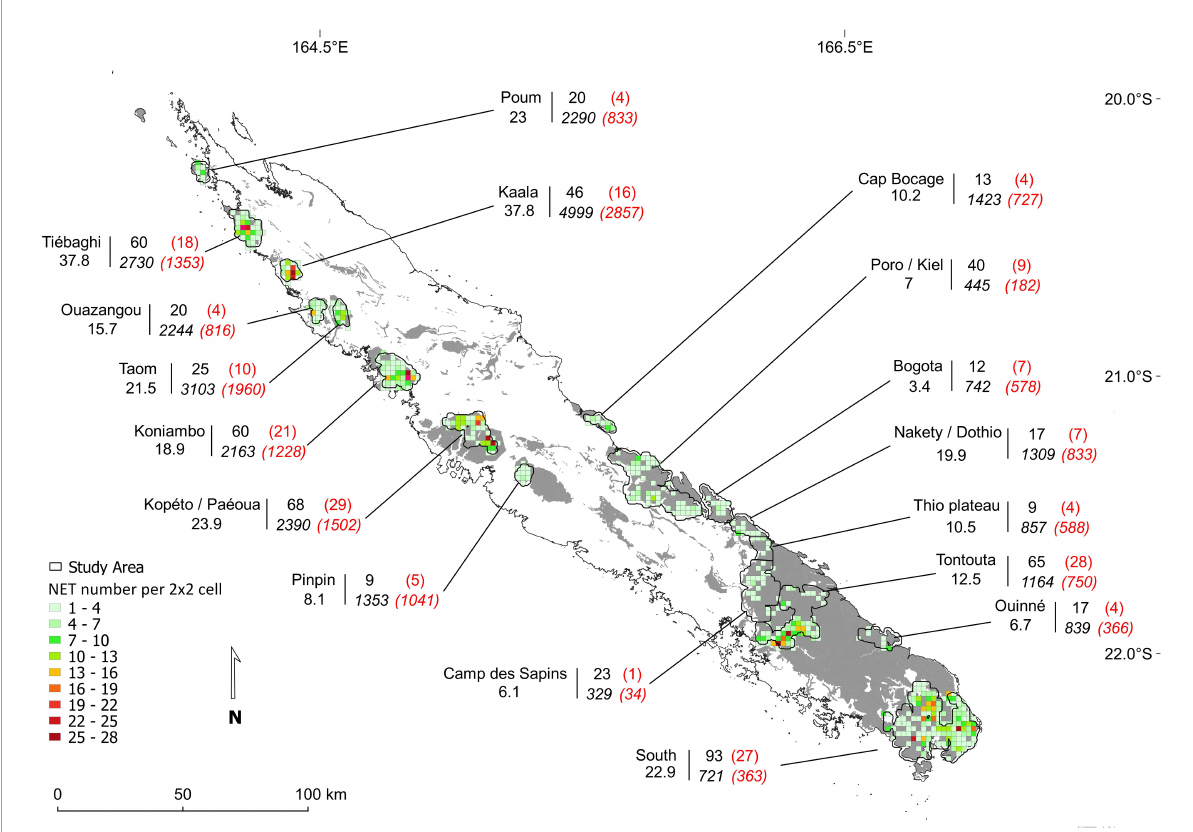
FIGURE4 Number of narrow endemic taxa (NET) per 2 × 2 km cells within the study area (circled in black). Divisions in the study area correspond to locally accepted “mining regions.” The number below each region’s name represents the sampling effort (occurrences per km 2 ). The numbers next to the region name correspond, on the upper line, to the total NET number in the region (in black) and the number of NET 1 (in red and brackets). On the lower line and italicised, are the corresponding endemism richness ratio computed for all NET (black), and NET1 only (red and brackets).